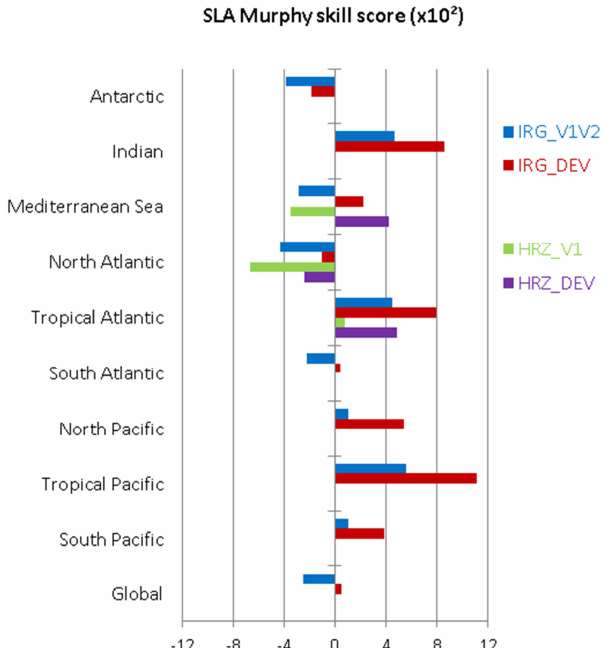
Fig. 17. Sea level anomaly Murphy skill score relative to persistence Fig. 17. Sea Level Anomaly Murphy skill score relative to persistence (x 100) for the main 2 ( × 100) for the main GODAE regions. These scores are averaged GODAE regions. These scores are averaged over all seven days of the data assimilation 3 over all seven days of the data assimilation window, with a lead window, with a lead time equal to 3.5 days. 4 time equal to 3.5days.